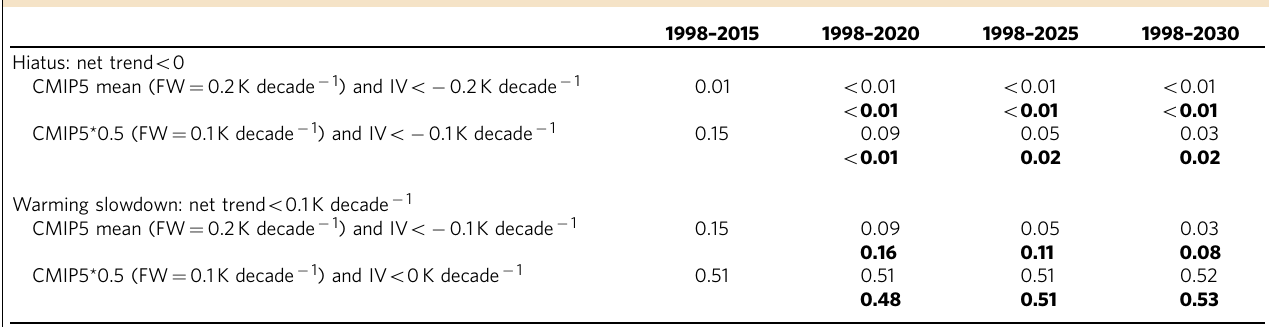
Table 1 | Probabilities of a hiatus or warming